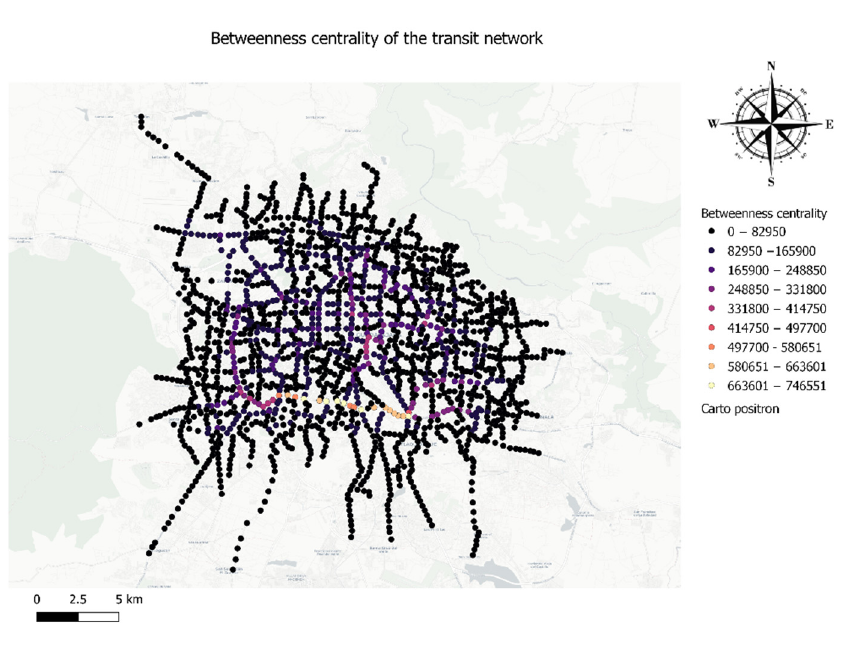
Figure 11. Betweenness centrality of the alternative network.